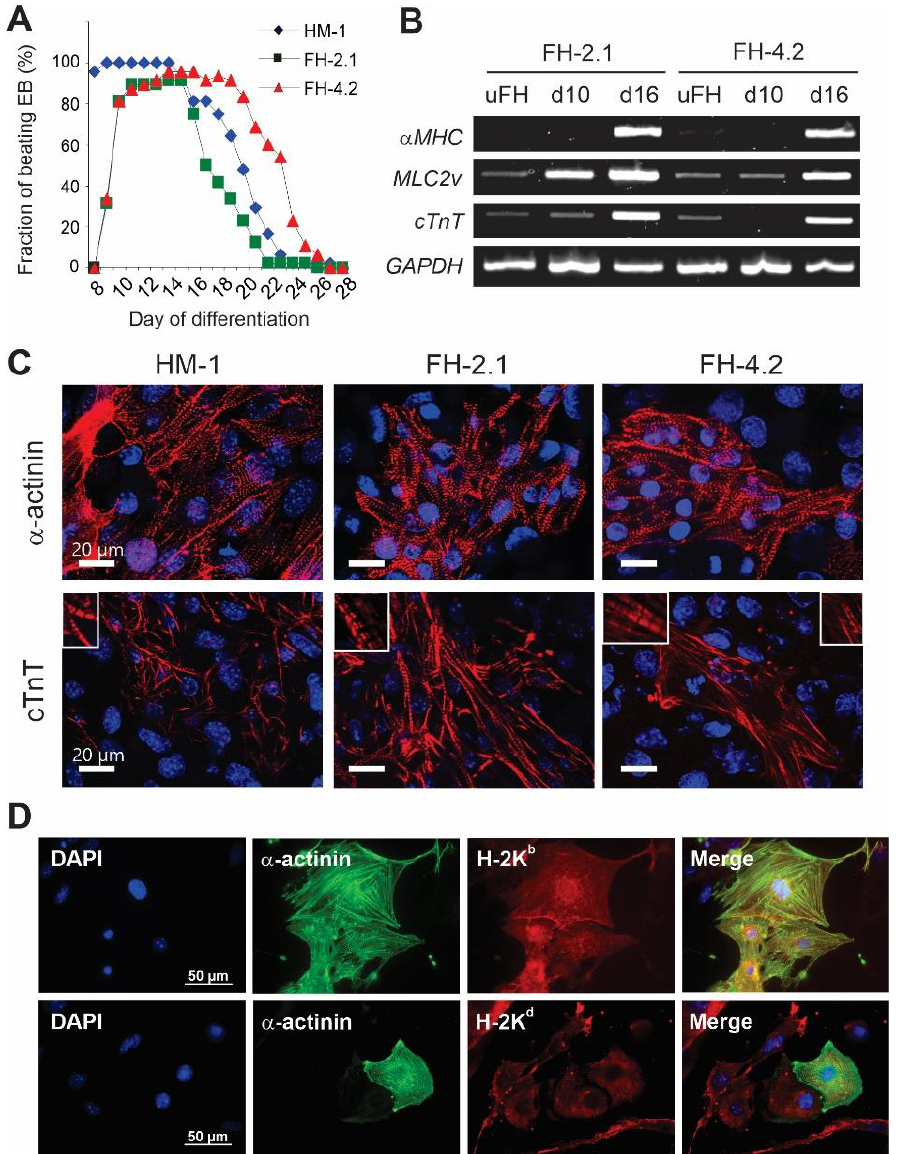
Figure 4. Cardiac differentiation of fusion hybrid PSCs. ( A ) The percentage of spontaneously beat- ing EBs was calculated at the indicated time points during differentiation. ( B ) Semiquantitative RT-PCR analysis of expression of cardiac-specific genes α MHC , MLC2v , and cTnT in EBs derived from FH-2.1 and FH-4.2 cells collected at day 10 (d10) and day 16 (d16) of differentiation. Undiffer- entiated FH cells (uFH) were included as controls, and GAPDH was used as a housekeeping gene. ( C ) Immunocytochemical detection of α -actinin (upper panels) and cardiac troponin T (cTnT, lower panels) in beating areas derived from HM-1 ESCs, and FH-2.1 and FH-4.2 PSCs. Cardiac markers are shown in red. Scale bars: 20 µ M. ( D ) Immunocytochemical detection of α -actinin (green) and MHC class I molecules H-2K b and H-2K d (red) on FH-4.2 cells at day 16 of differentiation. Prior to staining, beating areas were trypsinized, single cells were plated on fibronectin-coated cover slides and treated for 2 days with IFN γ (100 ng/mL) to facilitate the detection of MHC class I molecules. These results demonstrate that all FH-PSC-derived cells, including CMs (green), express MHC class I molecules (red) of both fusion partners. Nuclei in all images were counter-stained with DAPI (blue). Scale bars = 50 µ M. The results of the validation of the specificity of antibodies used for the detection of H-2K b and H-2K d molecules are shown in Figure